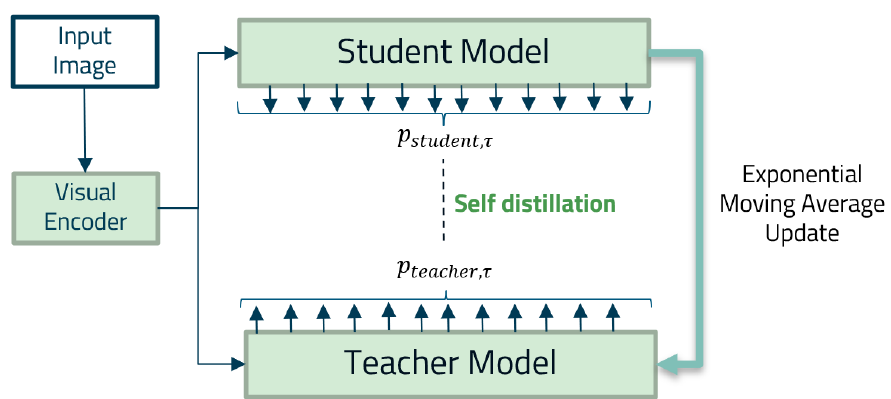
Figure 2. The interactions between our two language models: (1) the EMA update according to the student model’s weights. (2) The self - distillation process using the teacher model’s predicted logits passed to the student model, which will be treated as soft labels.